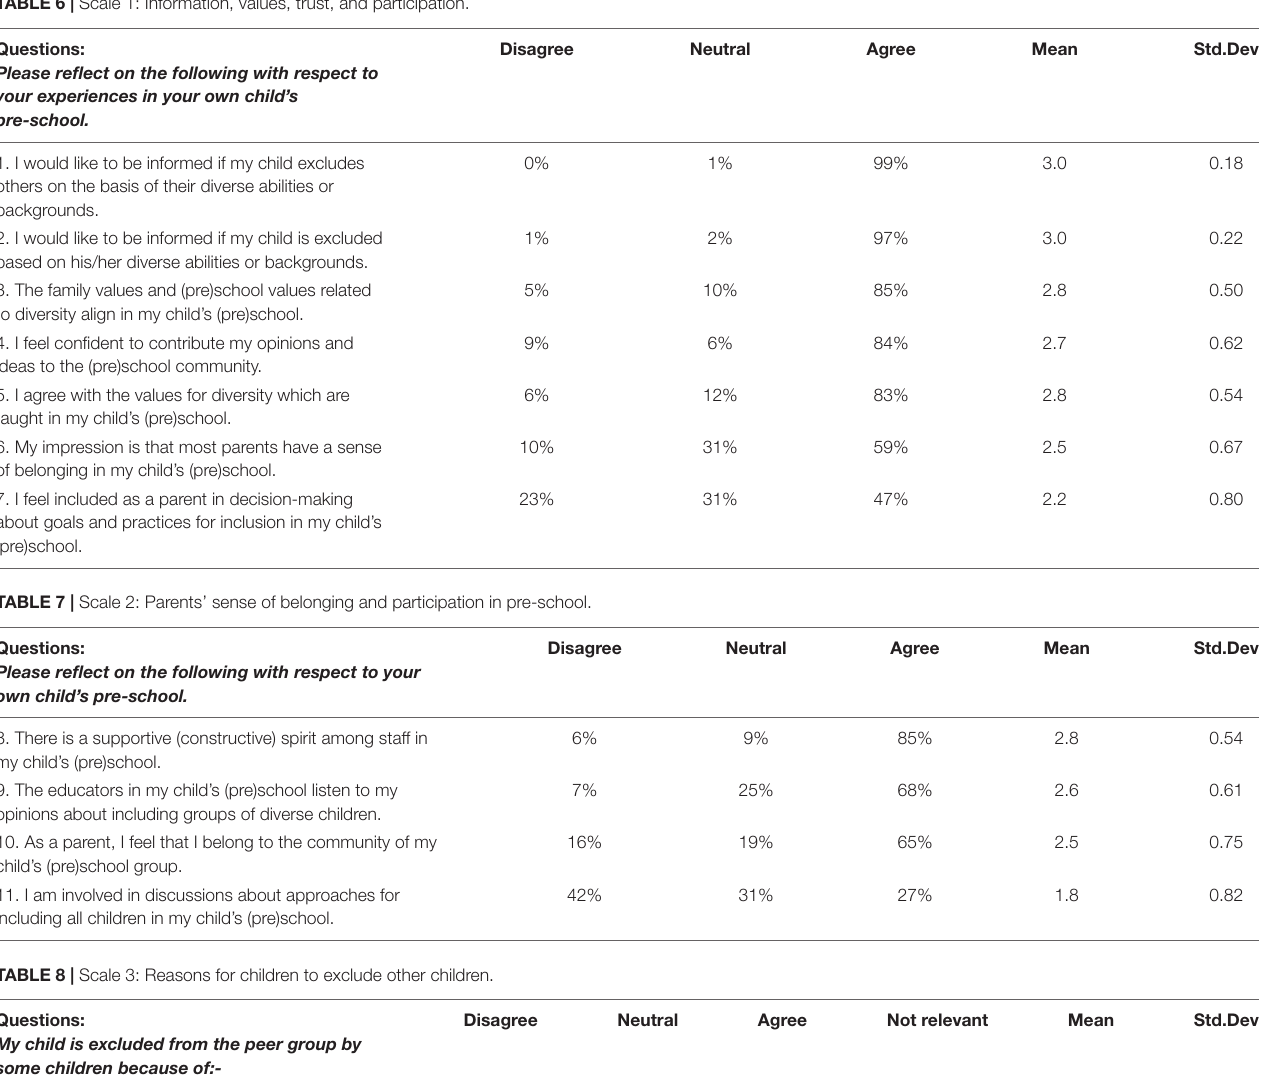
TABLE 6 | Scale 1: Information, values, trust, and participation. Questions: Please reflect on the following with respect to your experiences in your own child’s pre-school.